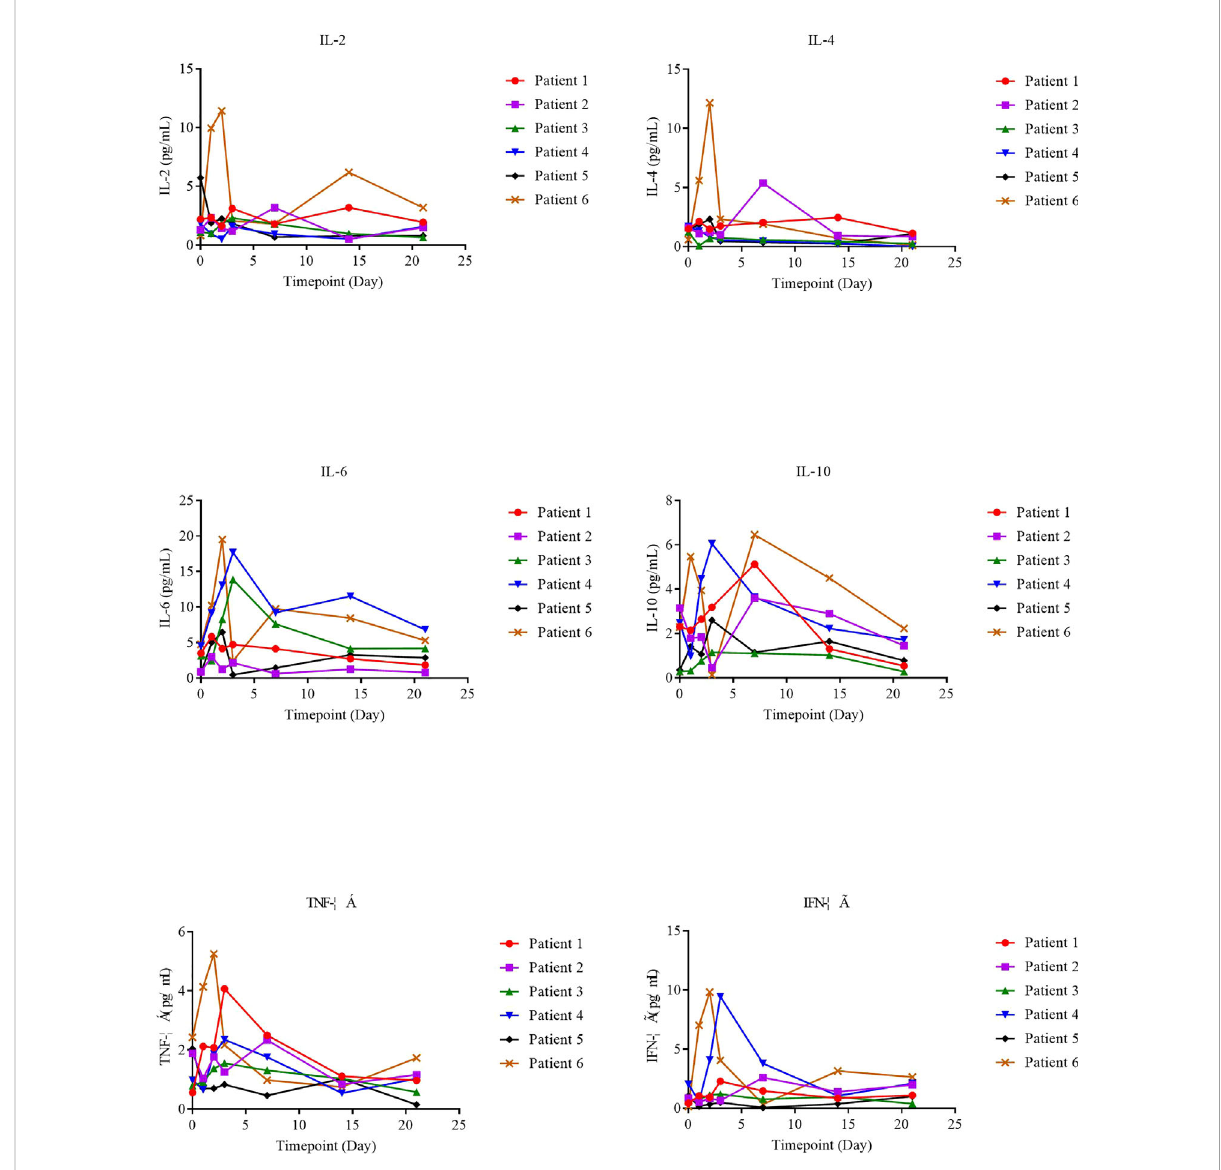
FIGURE 4 Serum kinetics of a panel of cytokines in 6 patients who received NAHTC